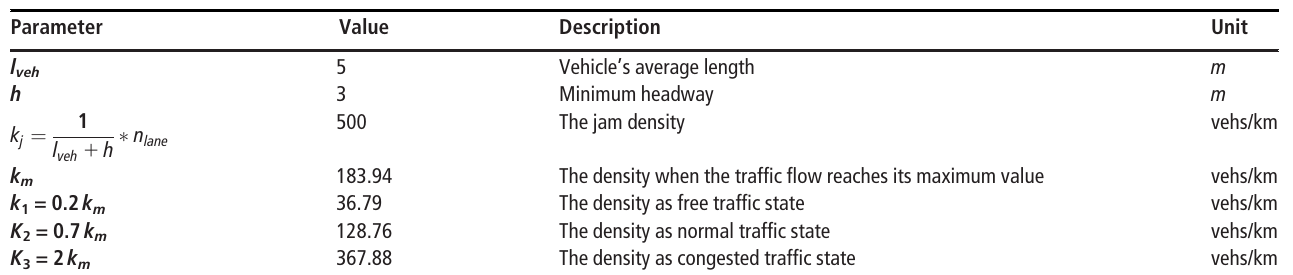
Table 2 Relevant parameters used to calculate traf fi c fl ow